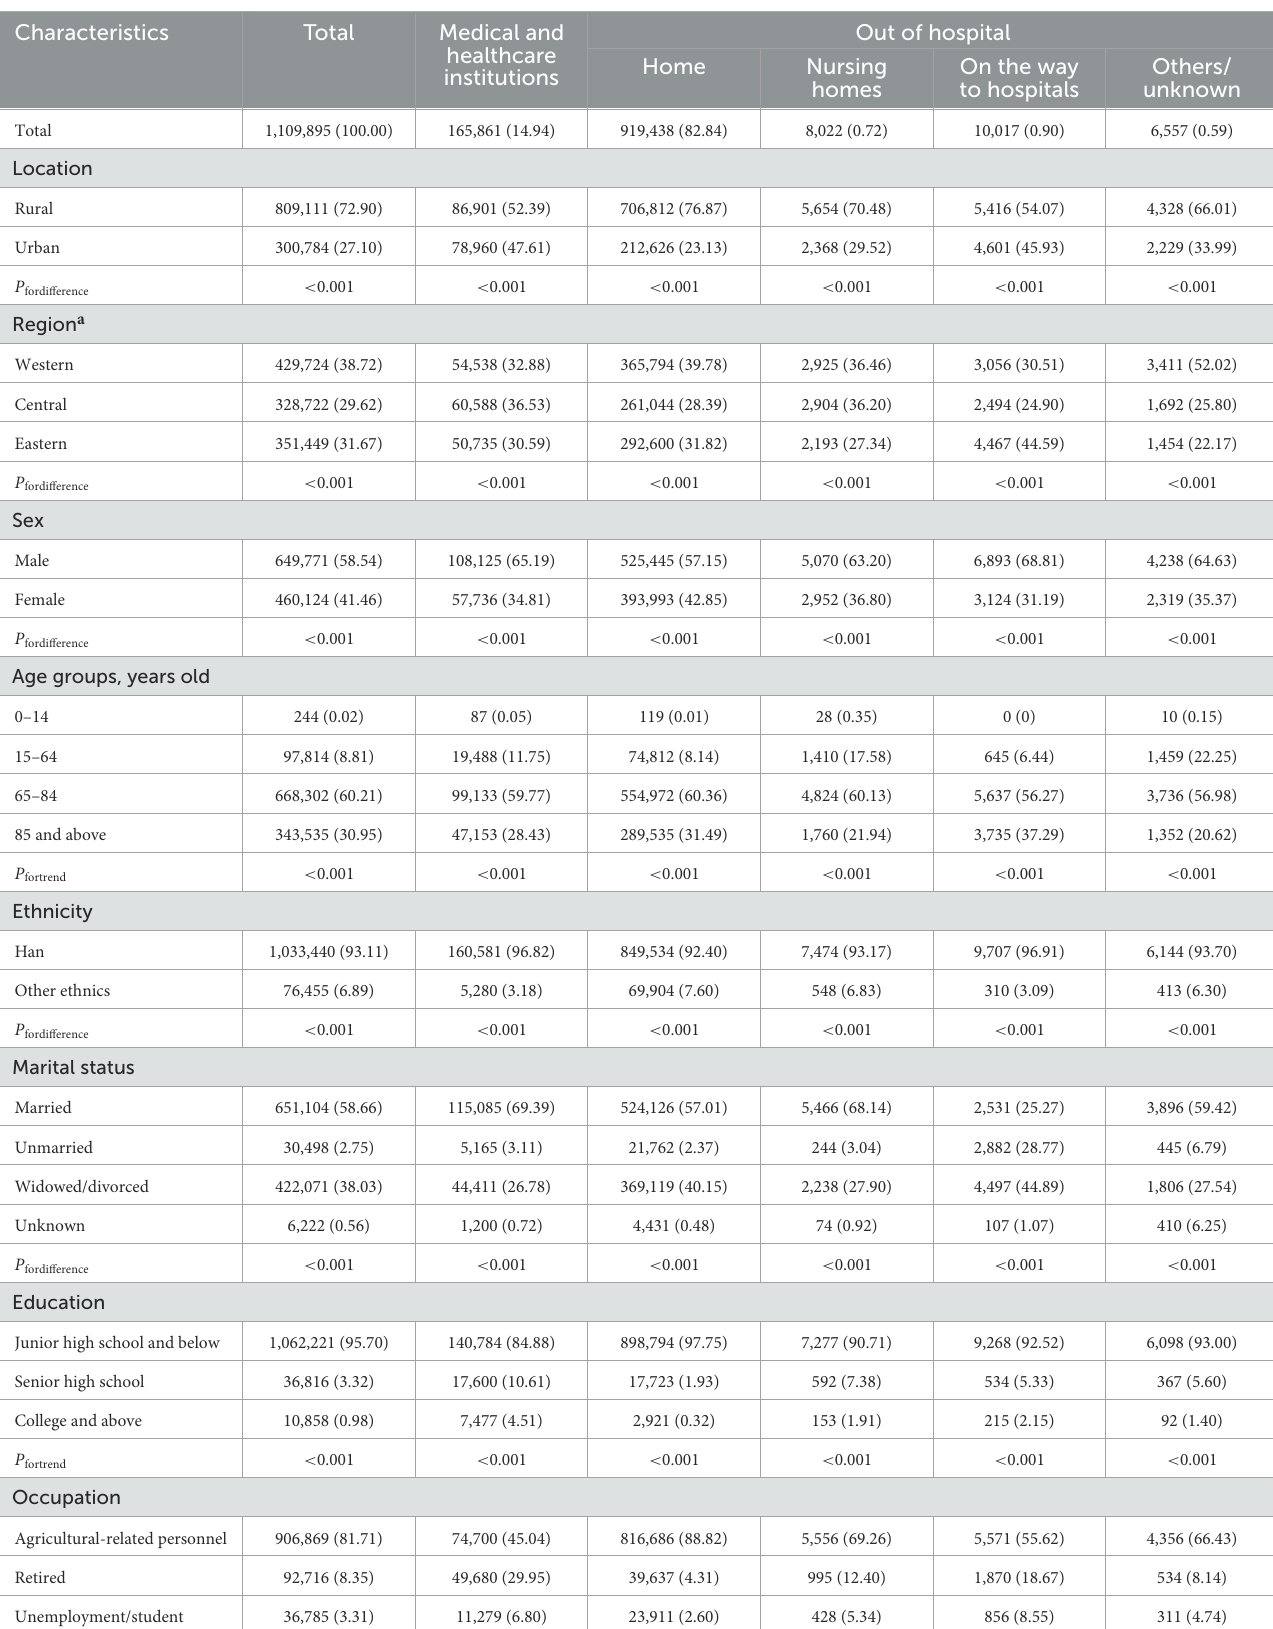
TABLE 1 Characteristics of POD distribution among CRD deaths from the NMSS in China, 2014–2020 [Death counts (person),